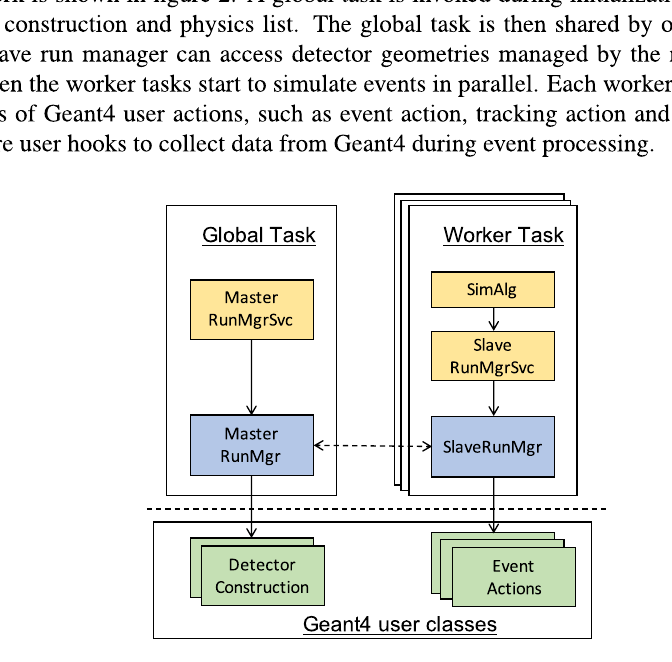
Figure 1. Schematic view of the JUNO